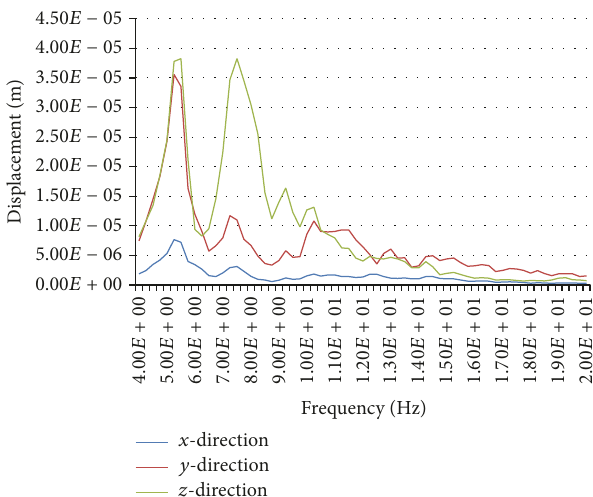
Figure 13: The FFT spectrums of Location